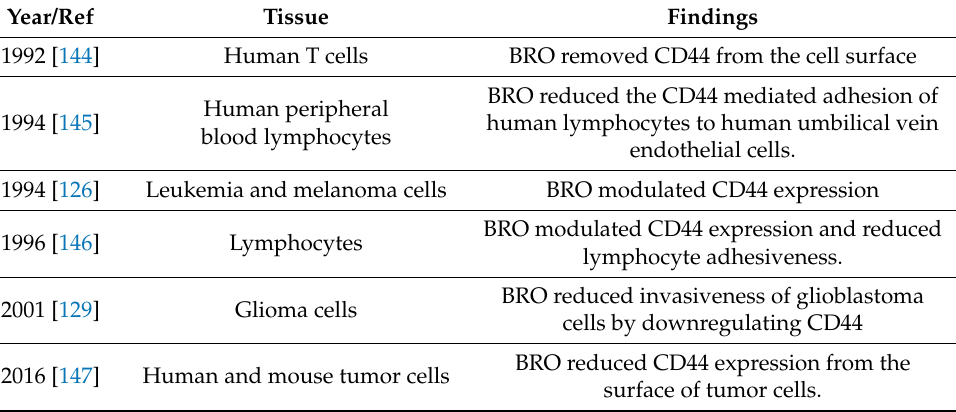
Table 3. BRO-CD44